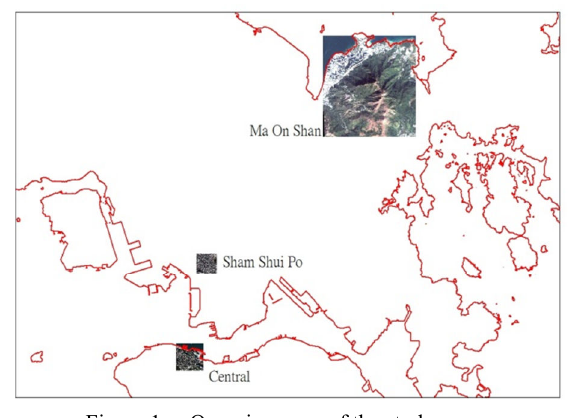
Figure 1. Overview map of the study areas